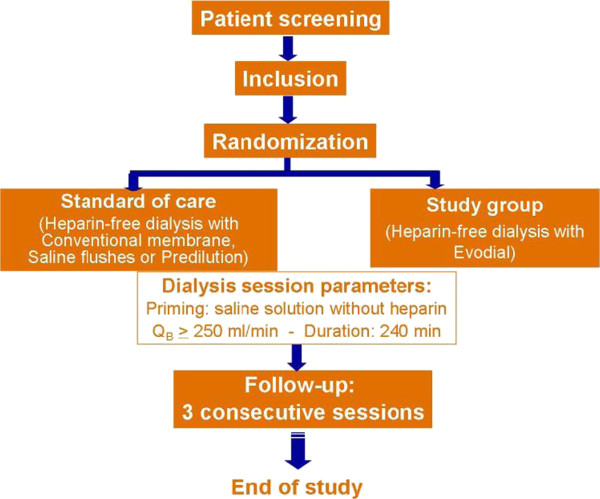
Study flow-chart.